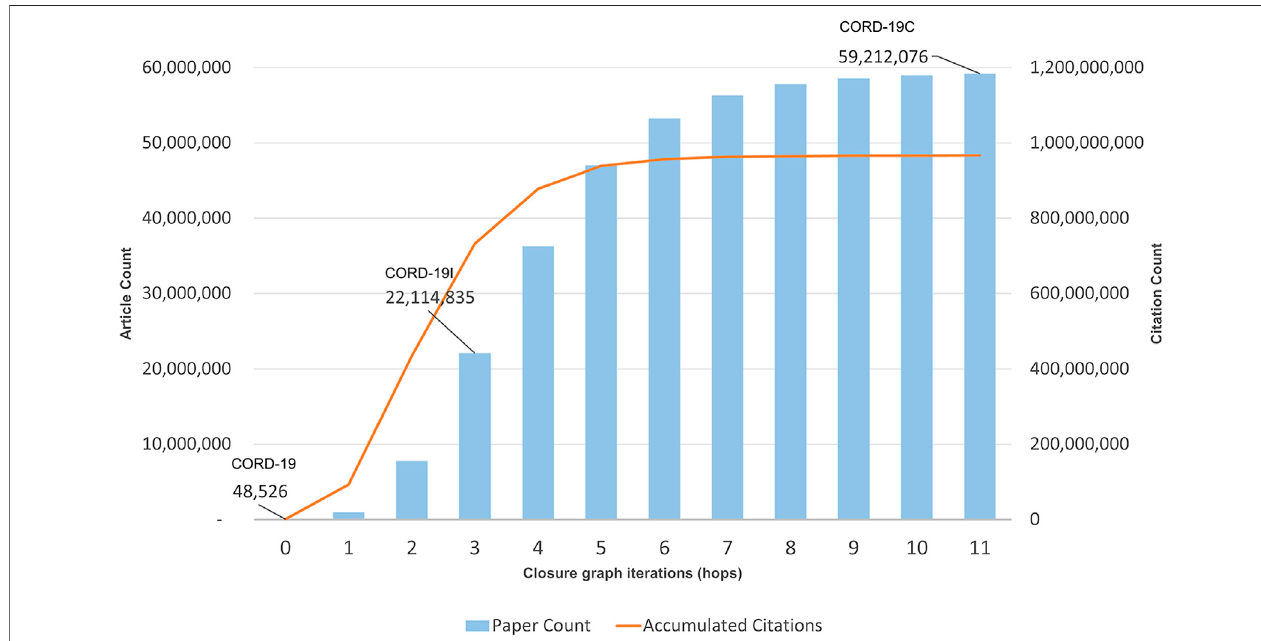
FIGURE 1 | Accumulated paper and citation counts per hop of the closure graph expansion. The callouts are article counts for COVID-19 Research Dataset (CORD-19) (seed), CORD-19I (hop 3), and CORD-19C (hop 11).